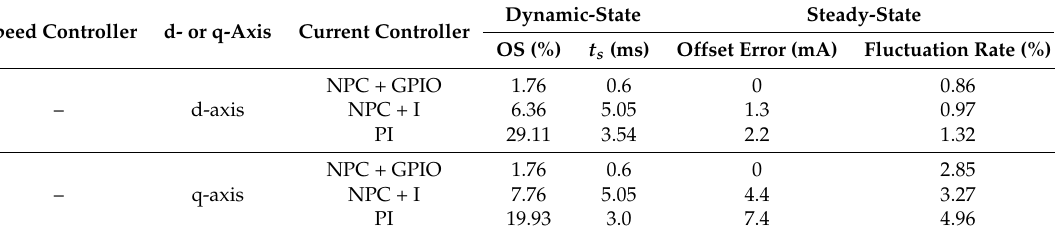
Table 4. Comparison of current-tracking performance indices in the case of model parameters